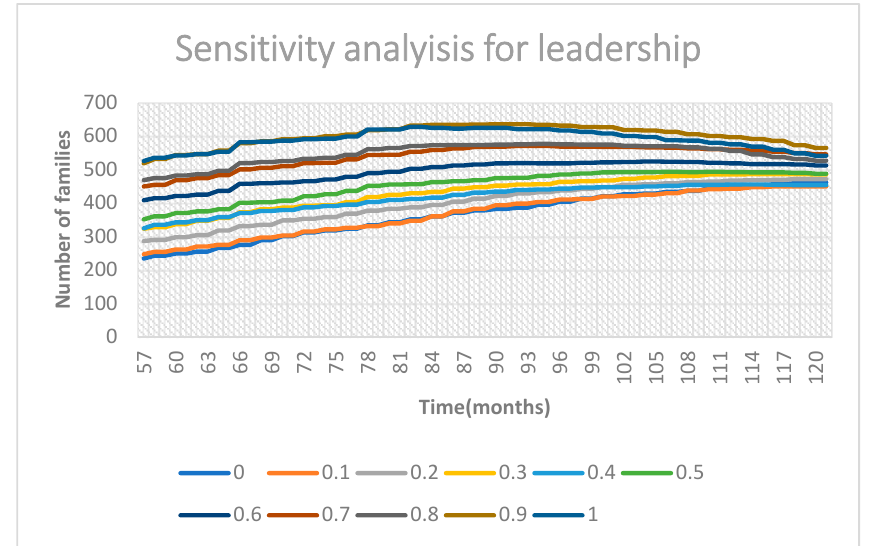
Figure 6. The effect of different weights of leadership on transformation outcomes.